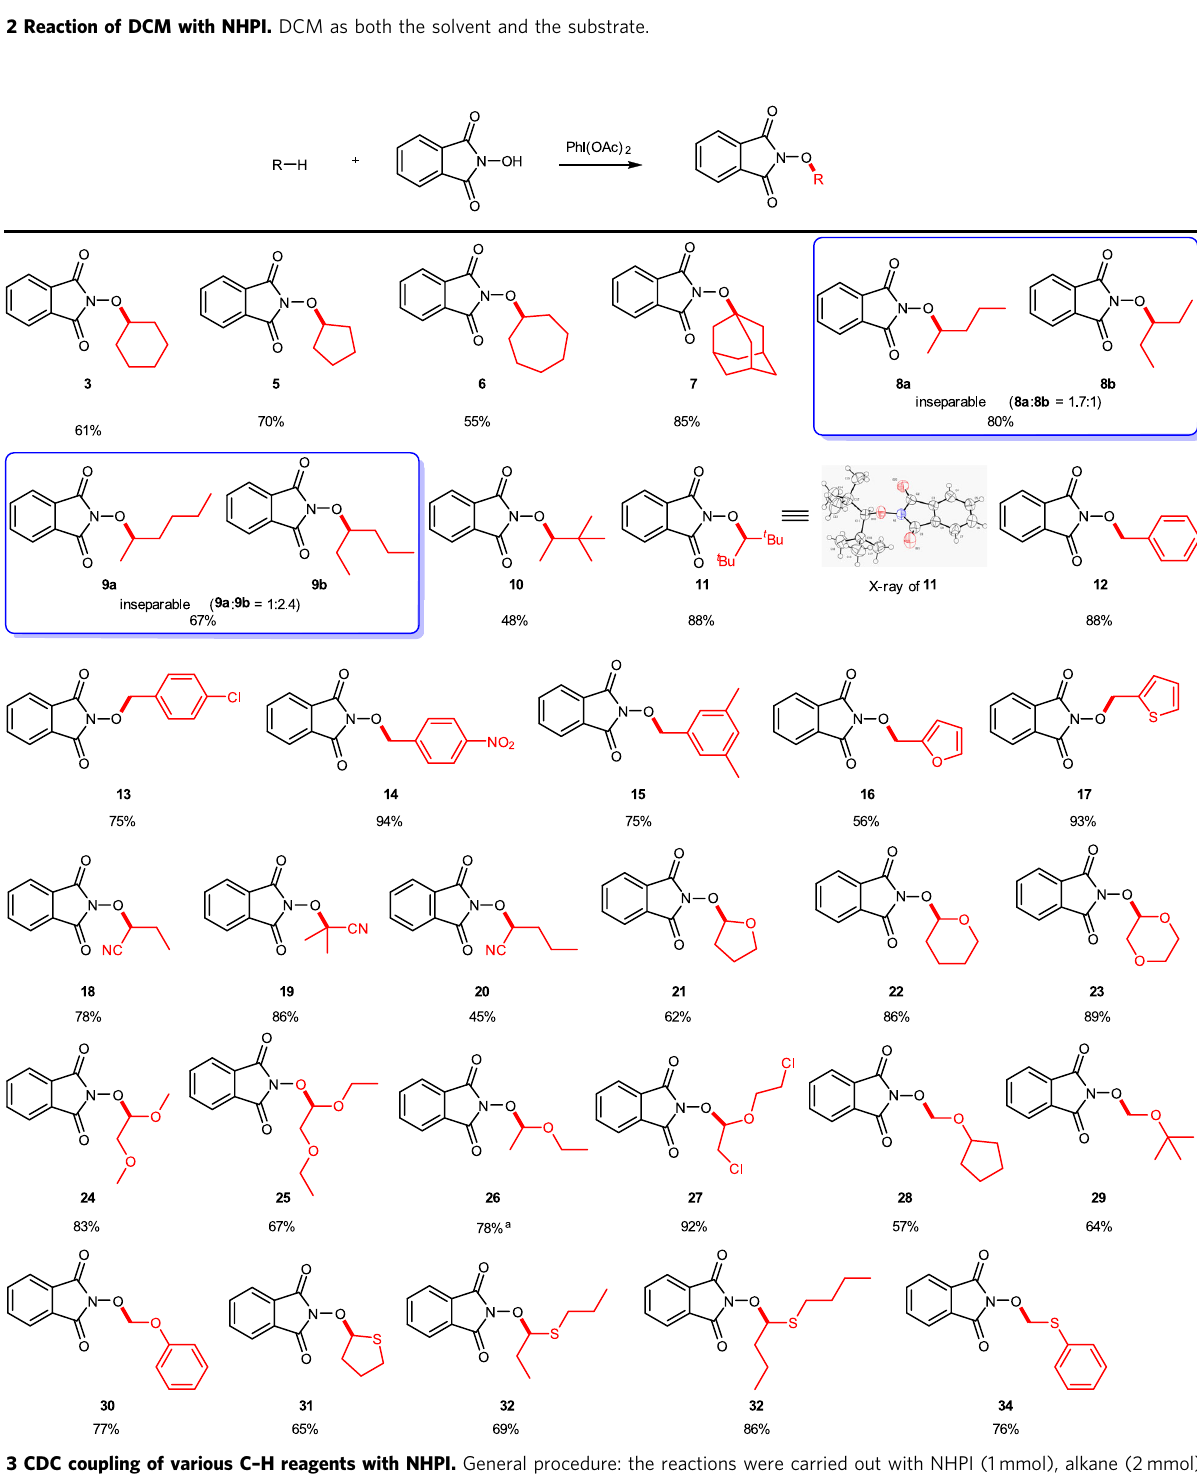
Fig. 3 CDC coupling of various C – H reagents with NHPI. General procedure: the reactions were carried out with NHPI (1 mmol), alkane (2 mmol), PhI (OAc) 2 (2 mmol) in DCM (2 mL) at room temperature for 2 h. Isolated yield. a The substrate (20 mmol) was used as the solvent.